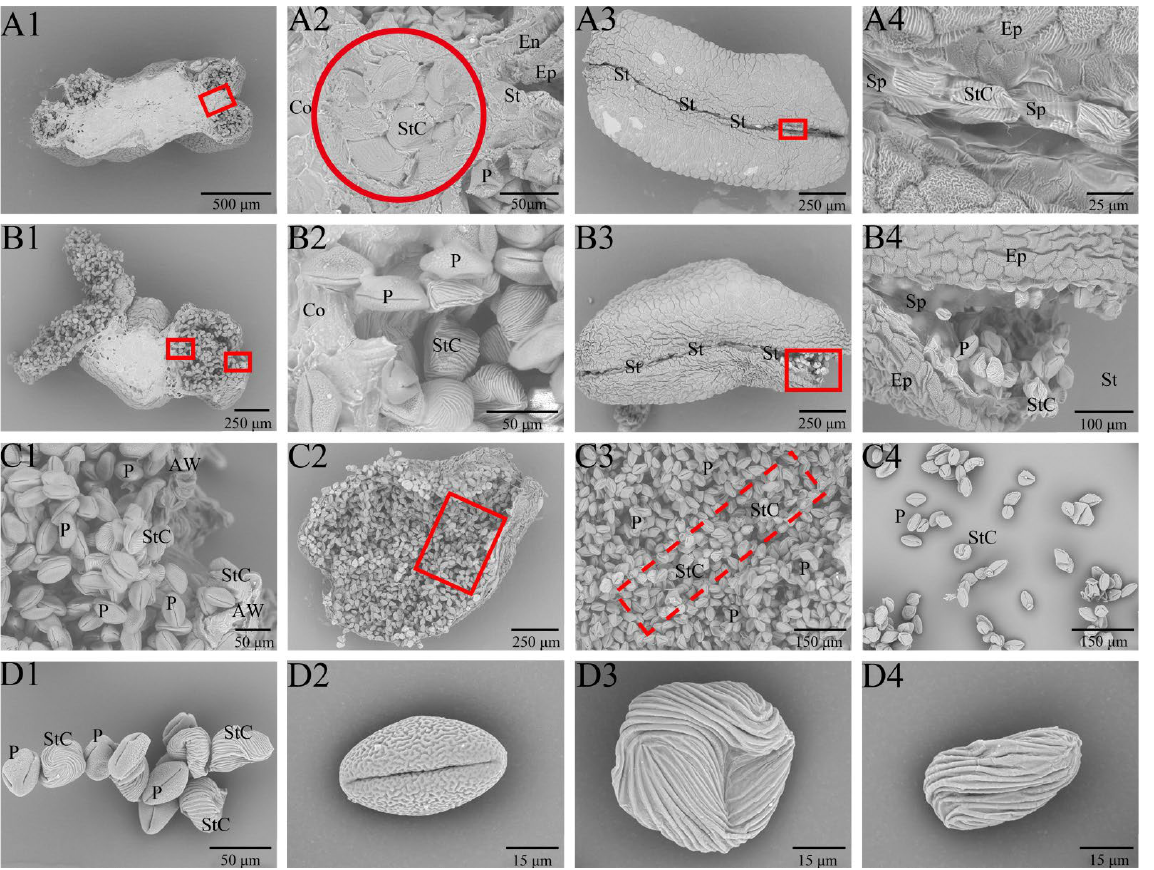
Figure 2. SEM observation of anther dehiscence in Camellia oleifera. ( A1 ): cross-section of C. oleifera anthers when they were not dehiscent; ( A2 ): enlargement of the red box in ( A1 ), and the red circle was a cluster of stomium cells, its cell wall with a striate shape. During this phase, the endothecium was not radially thickened in the stomium cells region, and the pollen grains were sunken inward; ( A3 ): the stomium of the anther about to be dehiscent; ( A4 ): enlargement of the red box in ( A3 ), where the septum was outside of the stomium cells. The stomium cells and epidermal cells were then subjected to dehydration to pull the septum. ( B1 ): anther dehiscence; ( B2 ): enlargement of the left red box in ( B1 ), where a large number of stomium cells were located at the site of stomium cell cytogenesis; ( B3 ): anther dehiscence due to septum dehiscence at the stomium, where stomium cells and epidermal cells were subjected to dehydration for dehiscence; ( B4 ): enlargement of the red box in ( B3 ), with the anther dehiscing at the stomium. The stomium cells and pollen were mixed at the stomium. ( C1 ): enlargement of the right red box in ( B1 ), where some of the labial cells stuck to the anther wall and adhered to the pollen against the outside with dehiscence activity; ( C2 ): anther dehiscence, with the stomium exposing a large number of pollen grains and stomium cells inside; ( C3 ): enlargement of the red box in ( C2 ), where the stomium cells were distributed under the stomium at the connection of two pollen sacs (inside the red dashed box), which was also the location of stomium cell cytogenesis; moreover, stomium cells were mostly located on the surface of pollen; ( C4 ): pollen and stomium cells mixed after sprinkling pollen on a conductive gel. ( D1 ): adherence of pollen and stomium cells; ( D2 ): the equatorial surface of pollen, where the outer wall of pollen was reticulate, exposing a germination furrow; ( D3 ): unhydrated stomium cells with the striate cell wall and a larger volume than pollen grains; ( D4 ): hydrated stomium cells with a smaller volume than pollen grains. AW, anther wall; Co, connective; En, endothecium; Ep, epidermis; P, pollen; Sp, septum; St, stomium; and StC, stomium